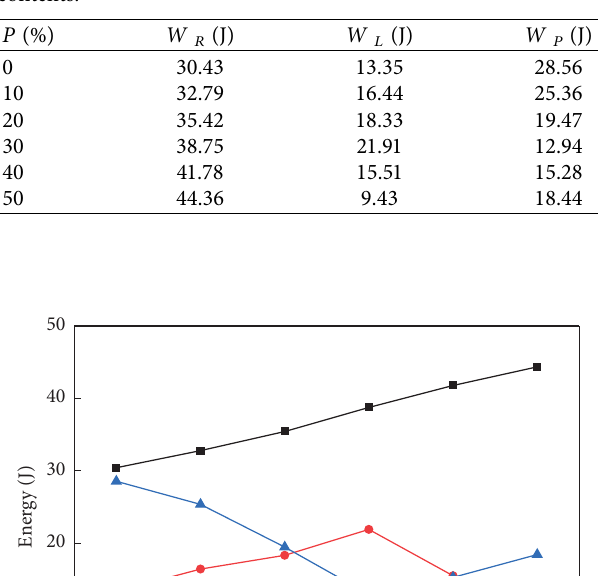
Table 5: Energy distribution of concrete with diferent fy